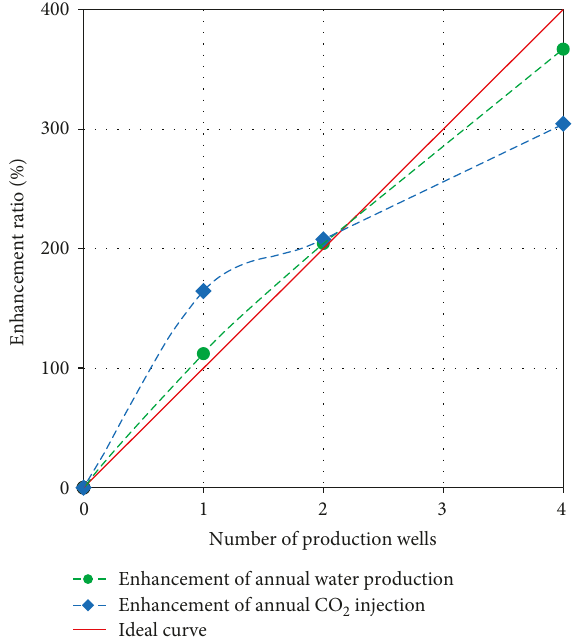
Figure 12: The enhanced e ffi ciency of the number of production wells on the CO injection and saline water production capacity. 2